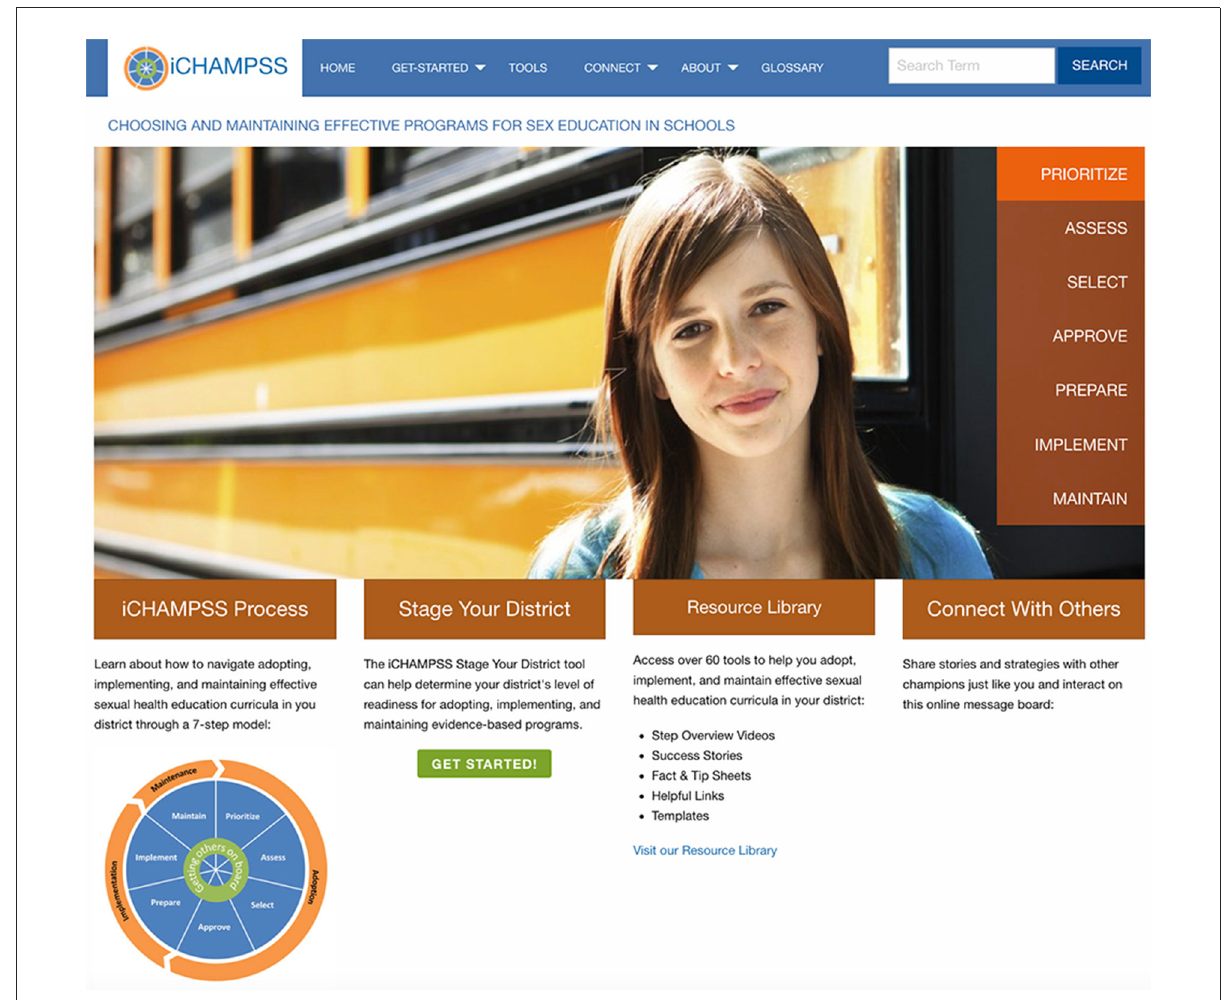
FIGURE1 The i CH oosing A nd M aintaining Effective P rograms for S ex Education in S chools (iCHAMPSS) online decision support